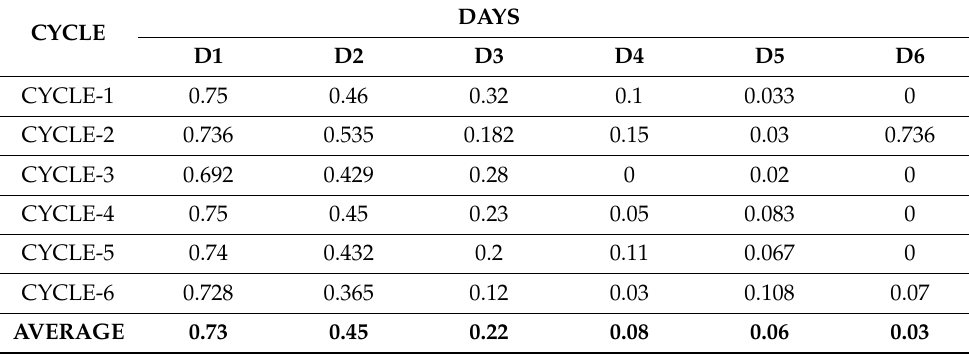
Table A3. Average probability of selling of breads per cycle per